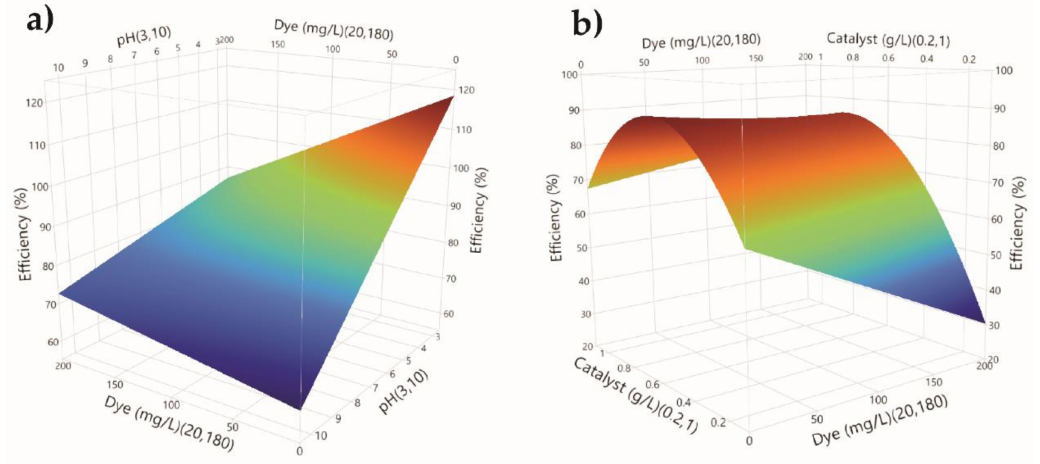
Figure 6. Diagram of the response surface of statistically significant interactions: ( a ) dye concentration and pH; ( b ) dye concentration and catalyst